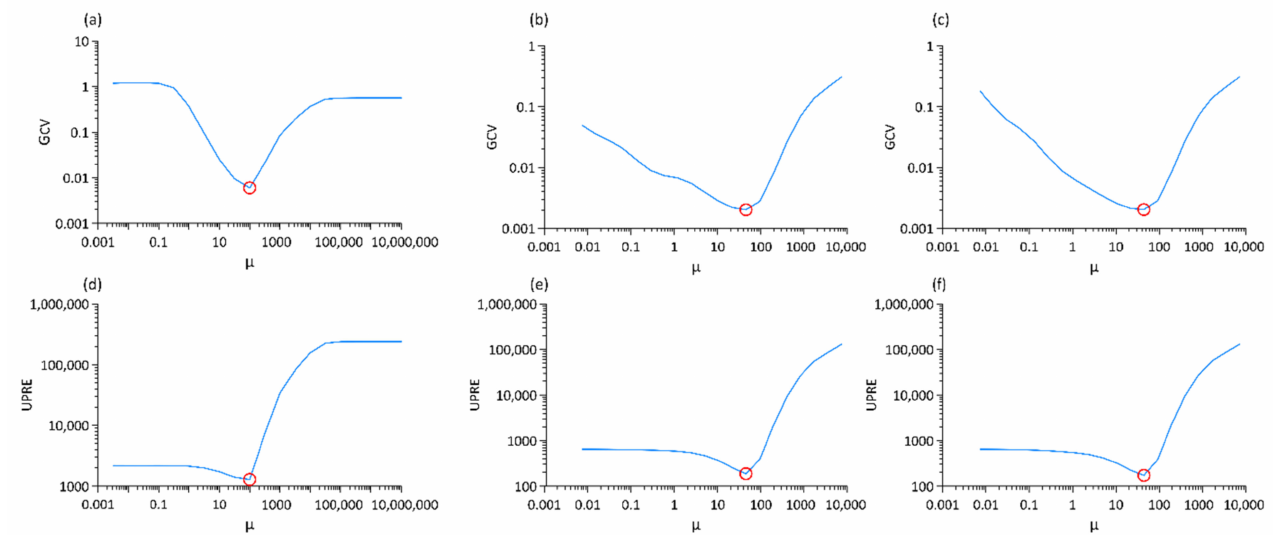
Figure 3. The GCV functions using ( a ) the CG method, ( b ) the GSVD, and ( c ) the RGSVD algorithm; the UPRE functions using ( d ) the CG method, ( e ) the GSVD, and ( f ) the RGSVD algorithm. The blue curve is GCV function or UPRE function, and the red is the optimal regularization (cid:35)